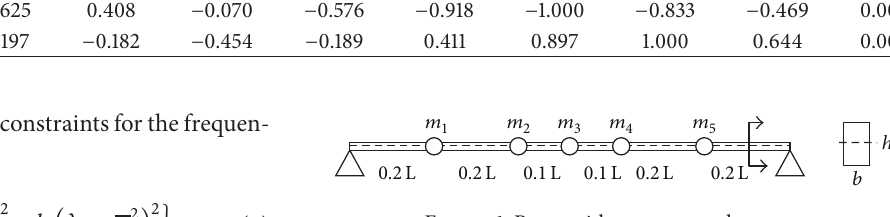
Figure 1: Beam with concentrated masses.